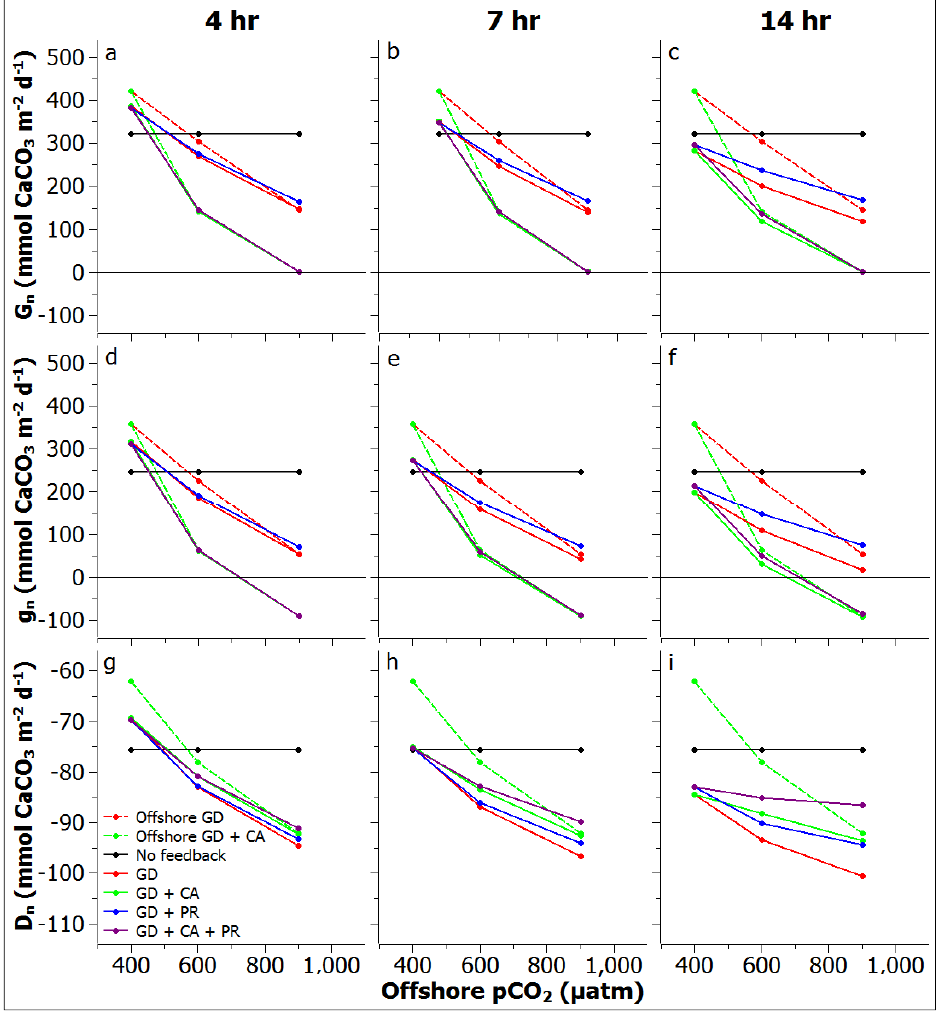
Figure 4. ( a – c ) Plots showing integral, daily net community calcification; ( d – f ) net ecosystem calcification; and ( g – i ) net community dissolution for the reef flat and the offshore reef edge as a function of offshore pCO for all model scenarios. Thin black line 2 ( a – f ) shows zero net calcification. Note difference in scale for net community